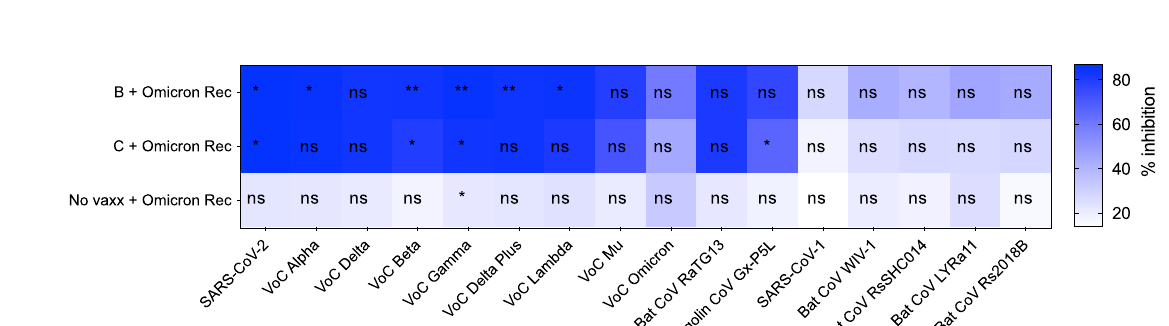
individual samples. a , b Signi fi cant differences in paired pre versus post vaccine responses within vaccine type by one-way Friedmans tests with Dunns multiple comparisons. * p <0.05, ** p <0.01, *** p <0.001, **** p <0.0001. Statistics shown for acute versus recovered ( b ), and ns between Coronavac and BNT162b2 Omicron recoveredsamplesbyOrdinaryone-wayAnovawSidak ’